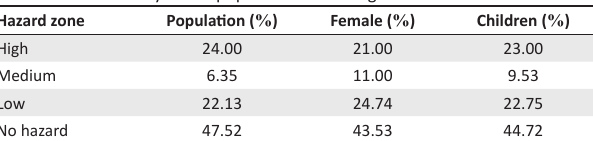
TABLE 7: Catchment-wise flood affected